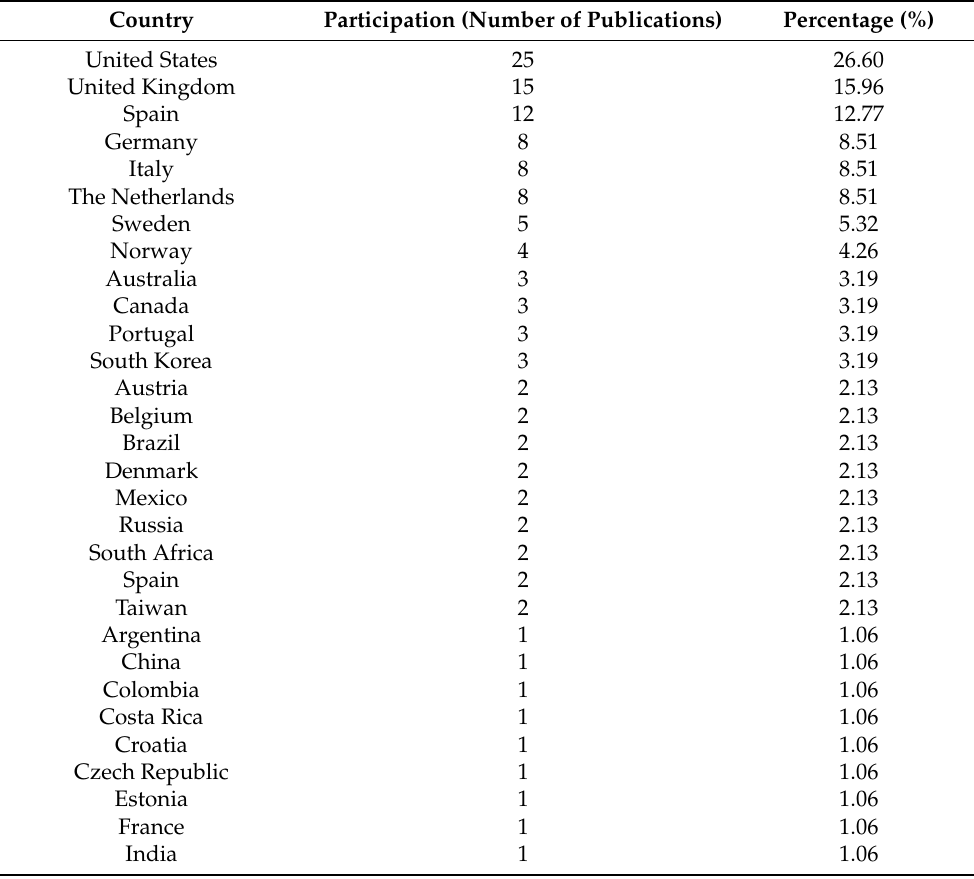
Table A2. Participation of analyzed countries in the number of